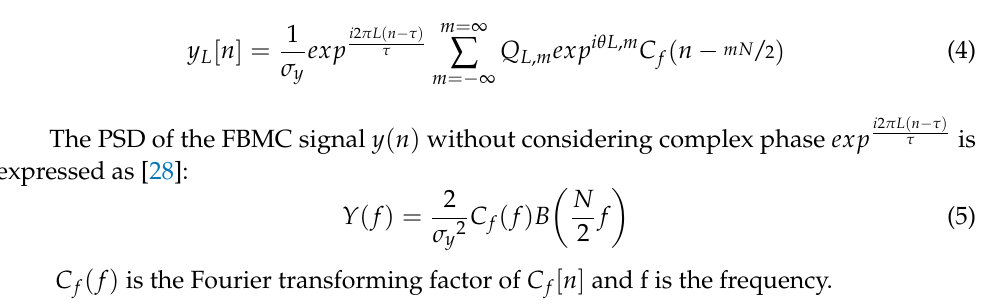
Figure 4. PSD of FBMC for L = 1, 2, 3, and 4.